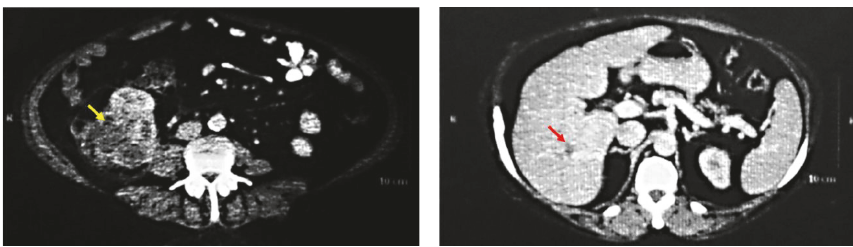
Figure 2: CT of Abdomen. Yellow arrow: mass attached to the right kidney (yellow arrow) on CT scan with bear paw sign. Red arrows: probably liver hemangiomas.